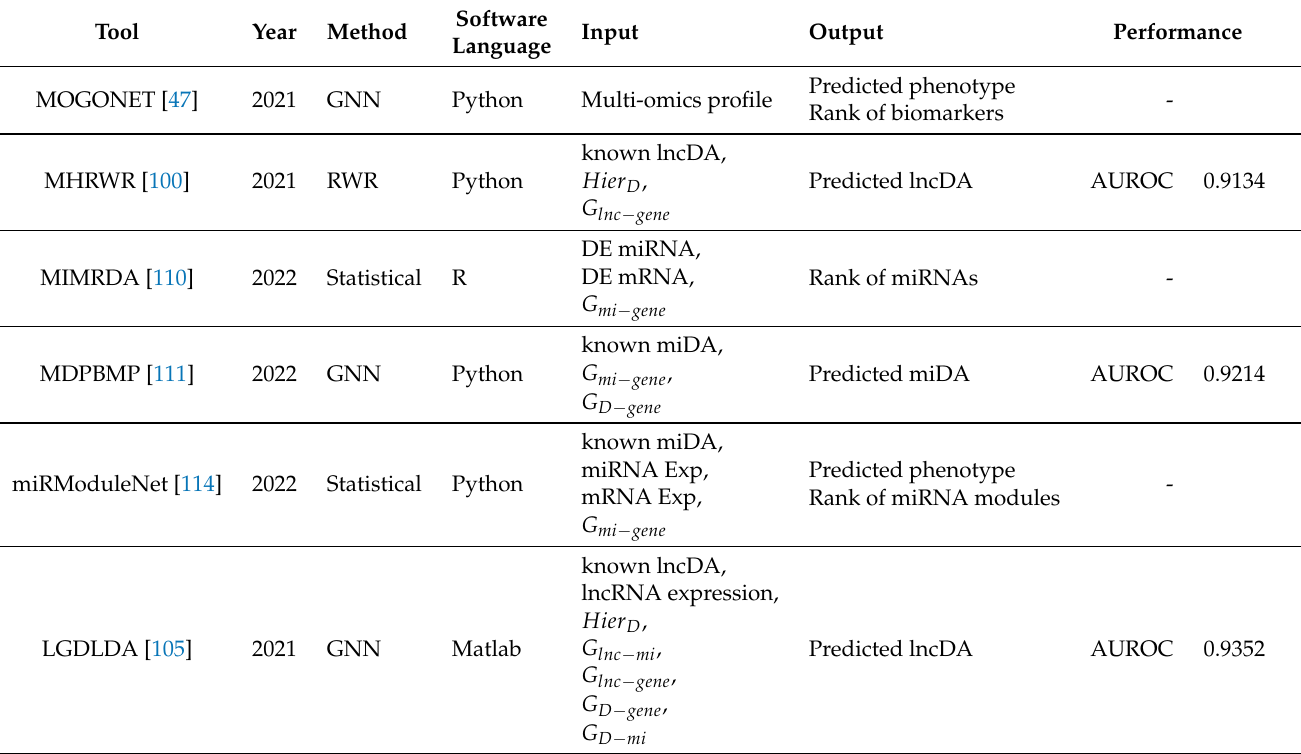
Table 4. Detailed information of representative ncDA predictive tools using